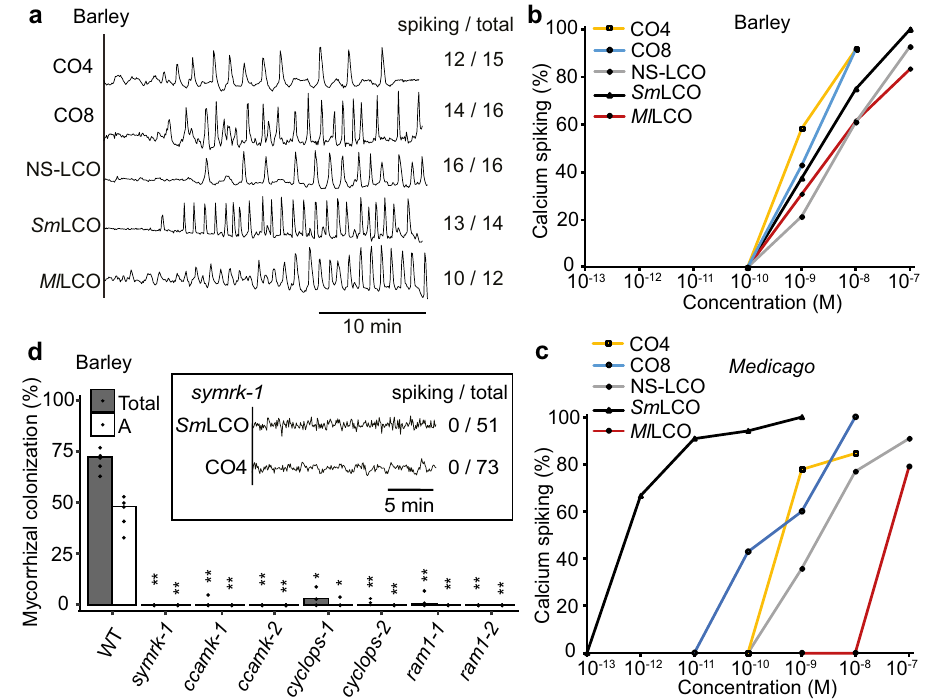
Fig. 1 | LCOs and COs activate calcium oscillations in barley. a Representative calcium tracesof atrichoblastsofbarley( H.vulgare )lateralrootsgrowninnutrient depletion, responding to 10 − 8 M CO4, 10 − 8 M CO8, 10 − 7 M NS-LCO (non-sulphated LCO produced by R. irregularis ), 10 − 7 M Sm LCO (LCO produced by S. meliloti ), and 10 − 7 M Ml LCO (LCO produced by Mesorhizobium loti ). Numbers indicate cells responding compared to total cells analyzed. Dose-response curves for LCO and COinductionofcalciumoscillationsinbarley( b )and M.truncatula ( c )lateralroots.